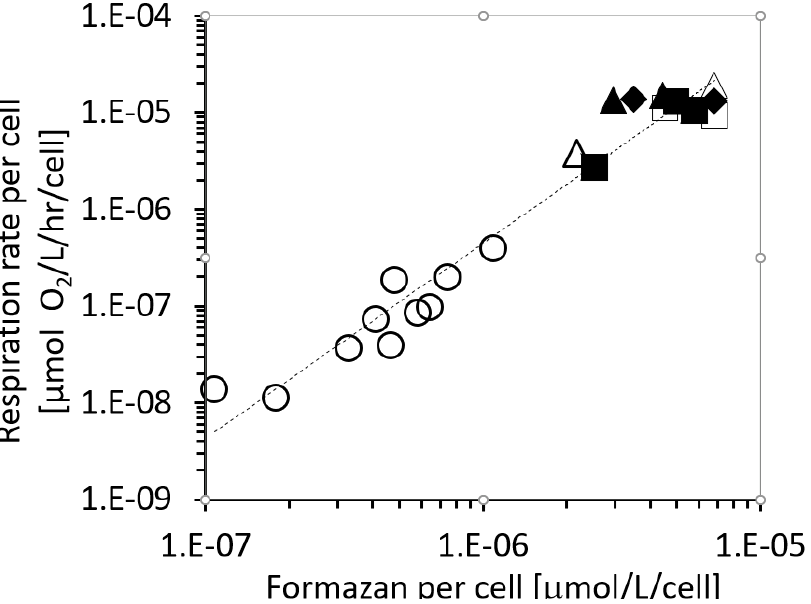
Figure S1. Respiration rate versus formazan production of communities of marine prokaryotes in continues cultures and V. harveyi in batch cultures. These are the same data as in Figure 1 and 2 but on linear scale. Continuous line; 𝑅 = 0.20𝐹 2.15 , r 2 = 0.93, confidence interval ( p ≤ 0.05) indicated by broken lines, symbols for temperature 10°C, 15°C, 18°C, 20°C, 25°C, 28°C.